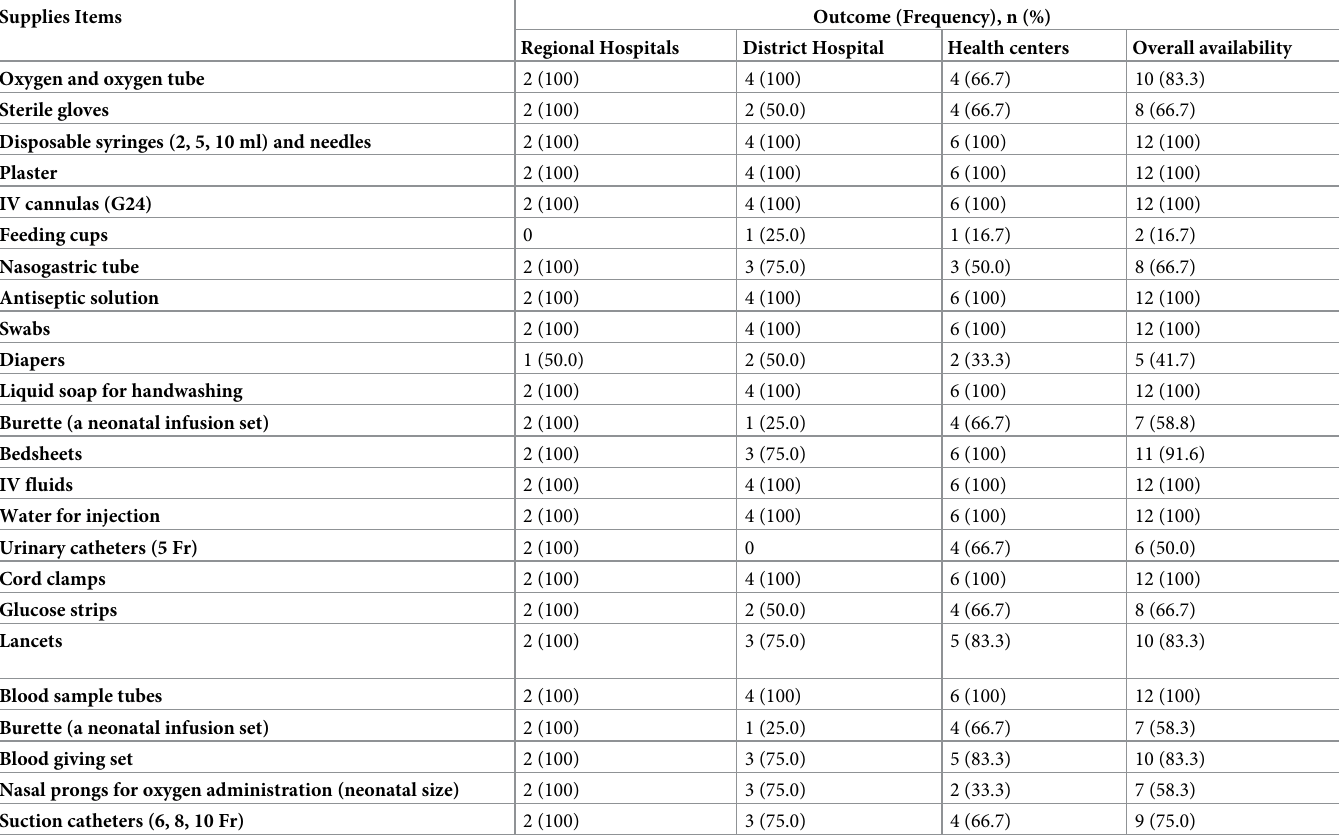
Table 5. Status of essential supplies at HFs with NCU/NSU, (N =